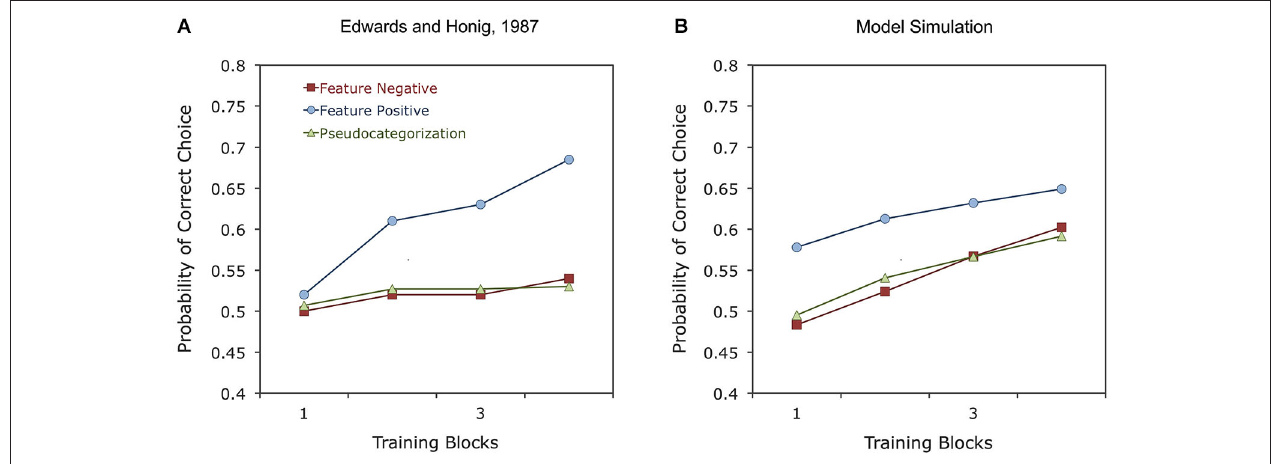
whereas in the feature-negative discrimination, objects from a category predict absence of reward. In the pseudocategorization task, different objects from the same category predict either reward or no